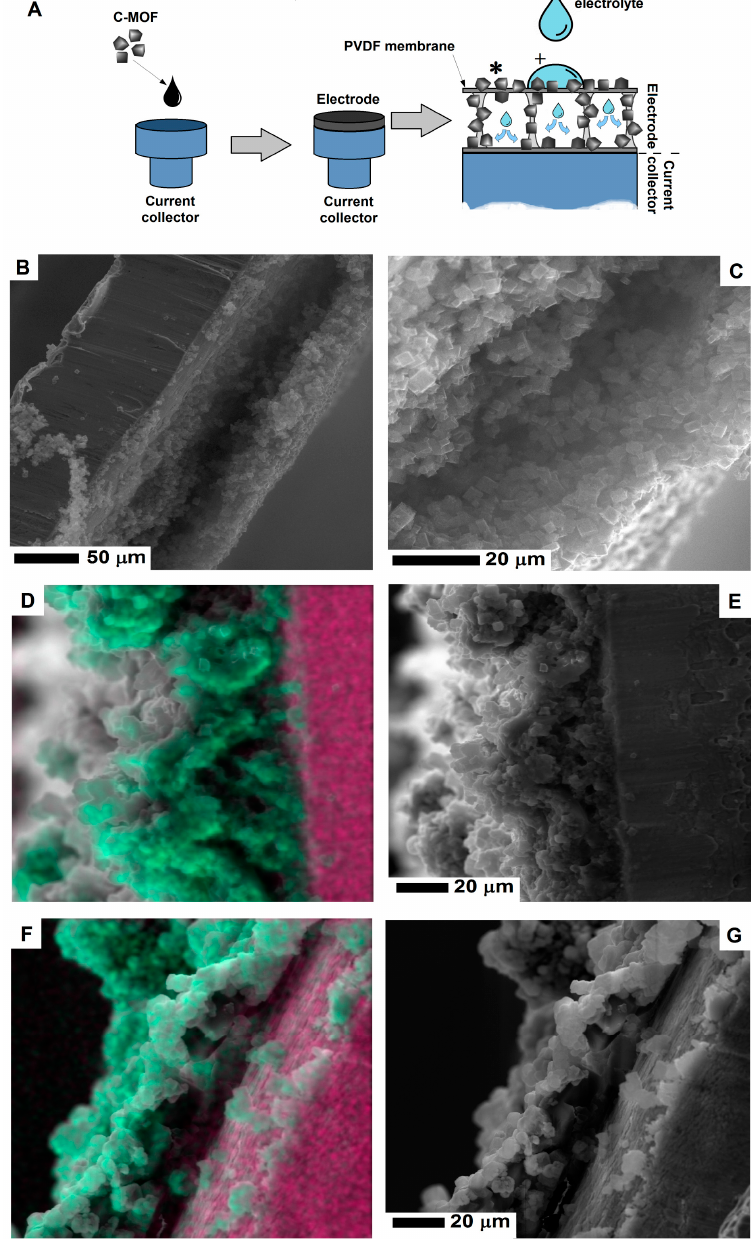
Figure 5. The scheme ( A ) of the electrolyte penetration of electrode and the SEM images of the electrode cross-section before ( B , C ) and after electrolyte penetration ( D , E and F , G ). The image in Figure 5D,F show the SEM images with a merge signal from potassium (green) and copper (pink) (To interpret the colors in this figure, the reader is referred to the web version of this article). The experiment scheme shows the spots of elemental mapping presented in Figure 5D,F, marked with (*) and (+) respectively. After electrode penetration, potassium hydroxide evaporates and leaves potassium traces.